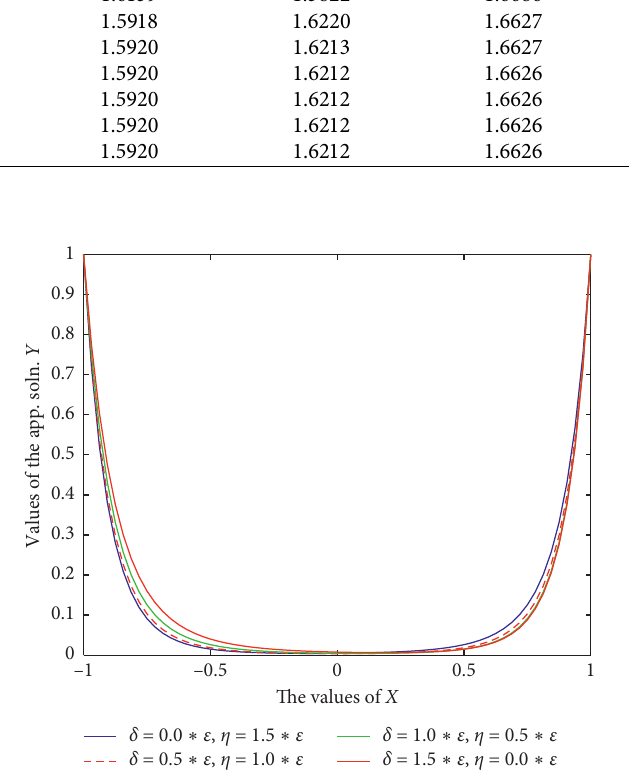
Figure 1: Plot of the solutions of Example 1 for ε � 0.1 and N �